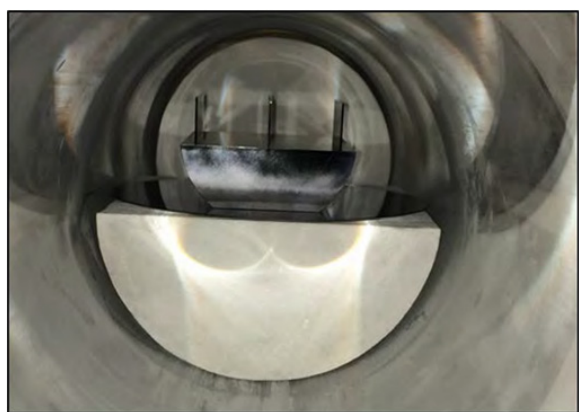
Figure 7. ‘Hera’ inside the tube furnace.